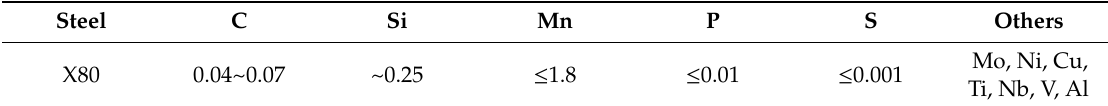
Table 1. Chemical composition of the X80 steel (wt. %).